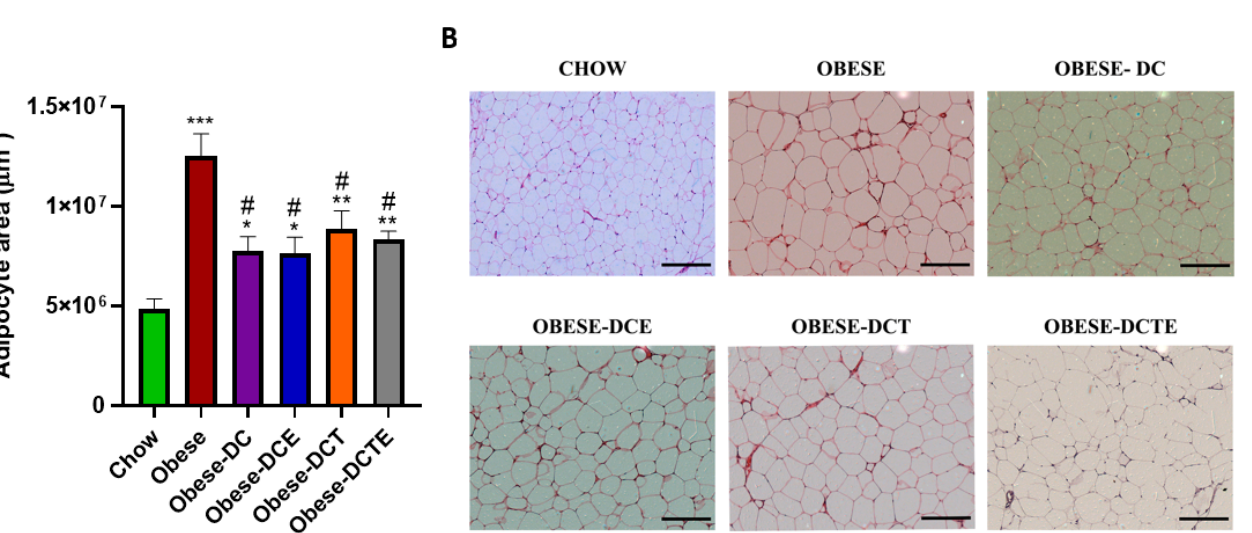
Figure 7. Gene expression of Monocyte Chemotactic Protein-1 ( A ), Interleukin 1 β ( B ), Interleukin 6 ( C ), Tumor Necrosis Factor α ( D ) NADPH oxidase 1 ( E ), NADPH oxidase 4 ( F ), Glutathione